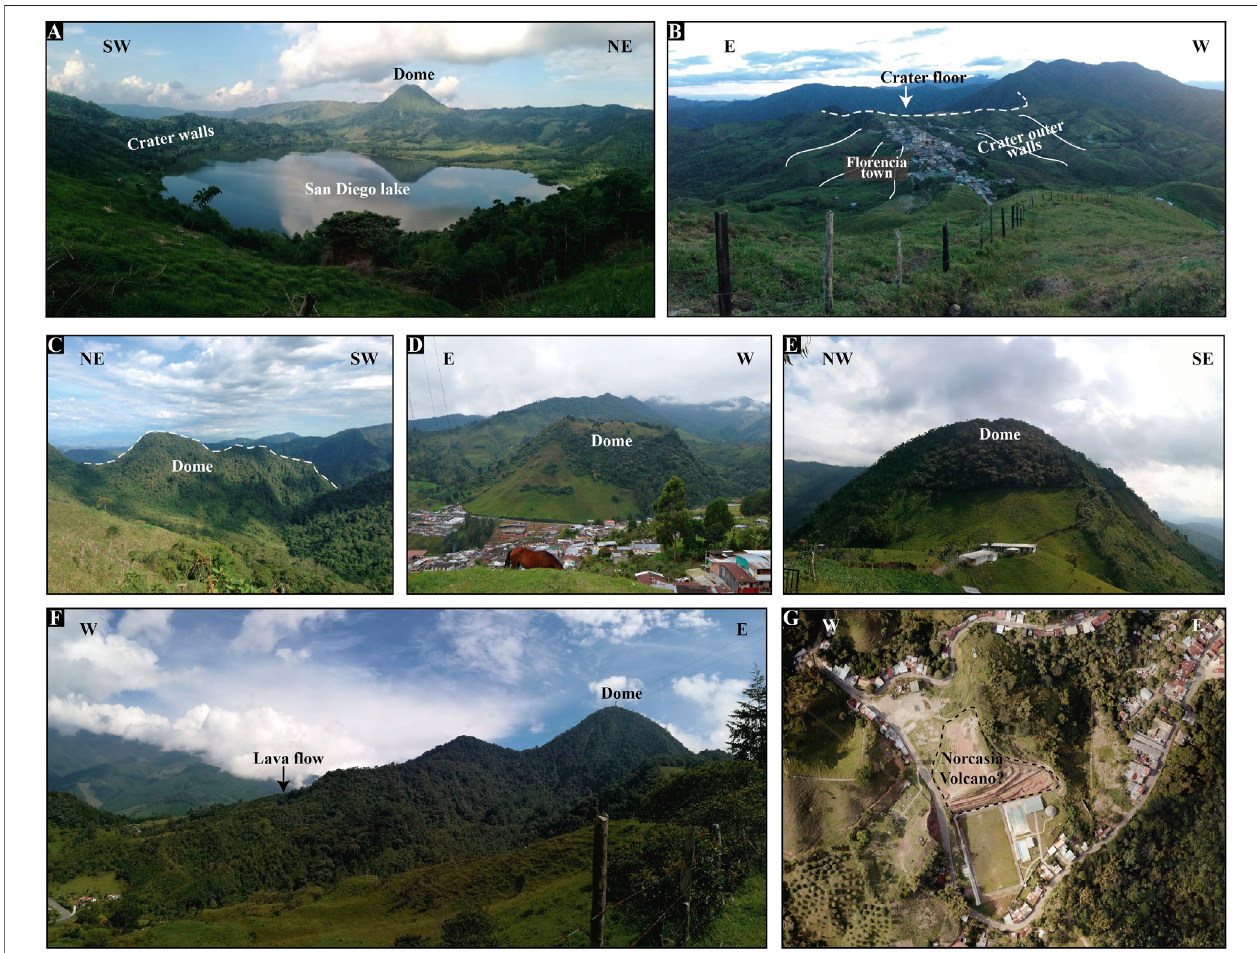
FIGURE 2 | Photographs of the volcanoes of Samaná monogenetic volcanic fi eld (A) San Diego maar. The lake is 1 km wide. (B) El Escondido tuff cone. (C) Pela Huevos dome. (D) Piamonte dome. (E) Morrón dome. (F) Guadalupe dome. Note the lava fl ow westward. (G) Norcasia volcano. It has an unde fi ned volcanic form; orthophoto: Carlos